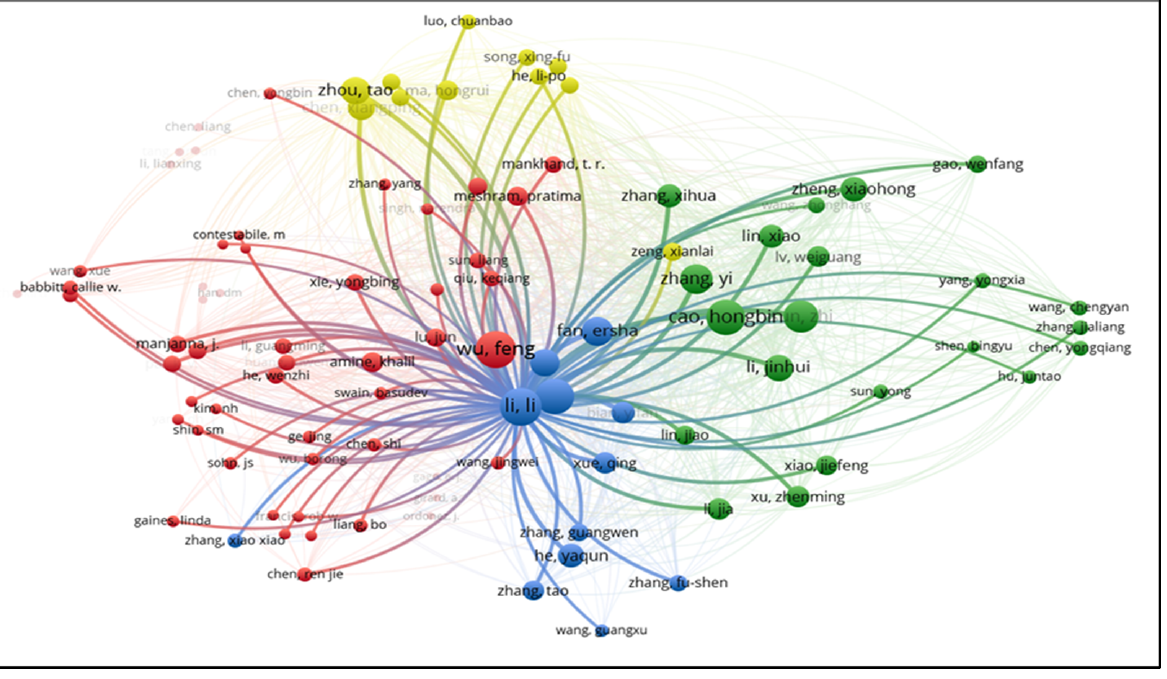
Figure 15. VOS Viewer Network Visualization Li, Li–Author with the greatest number of total